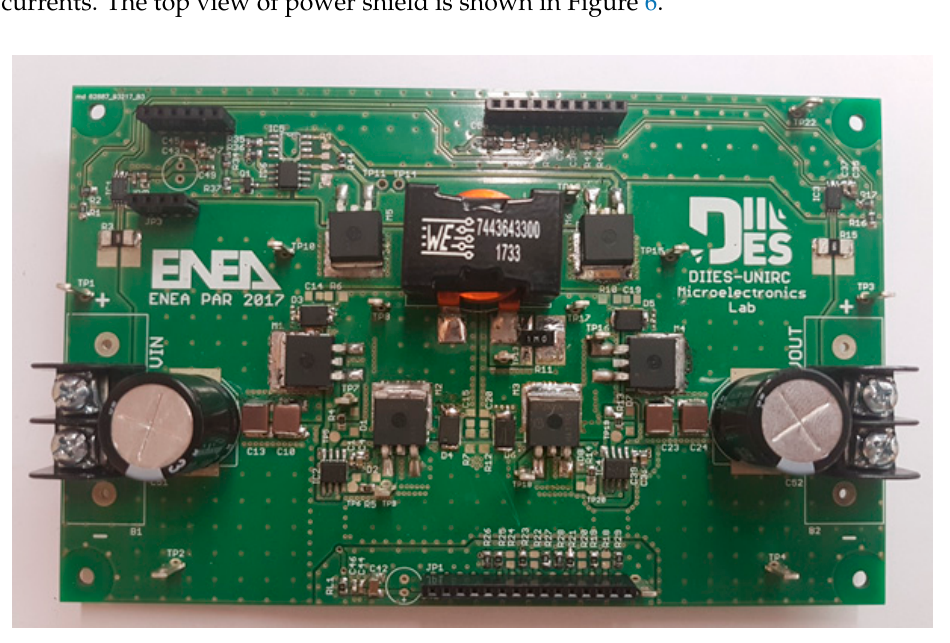
Figure 6. Power shield top view.